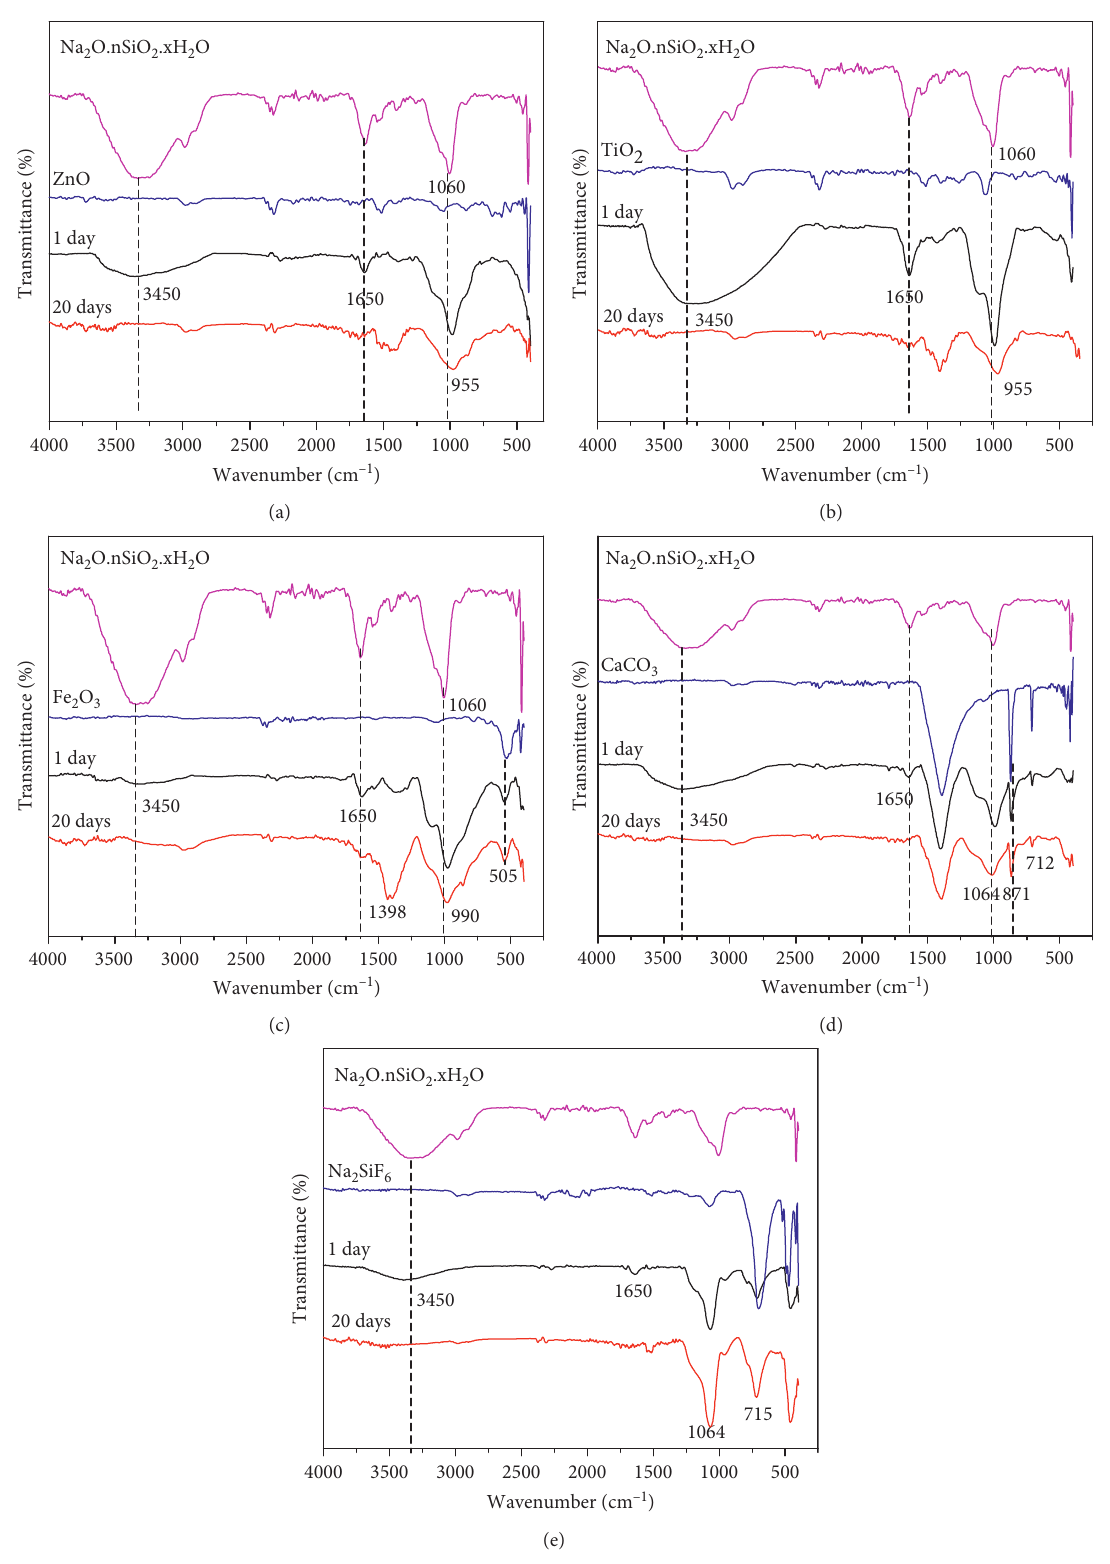
Figure 1: FT-IR spectra of ZnO-silicate (a), TiO 2 -silicate (b), Fe 2 O 3 -silicate (c), CaCO 3 -silicate (d), and Na 2 SiF 6 -silicate coating (e) at 1 day and 20 days of curing compared with extender pigments (ZnO, TiO 2 , Fe 2 O 3 , CaCO 3 , and Na 2 SiF 6 ) and Na 2 O.nSiO 2 .xH 2